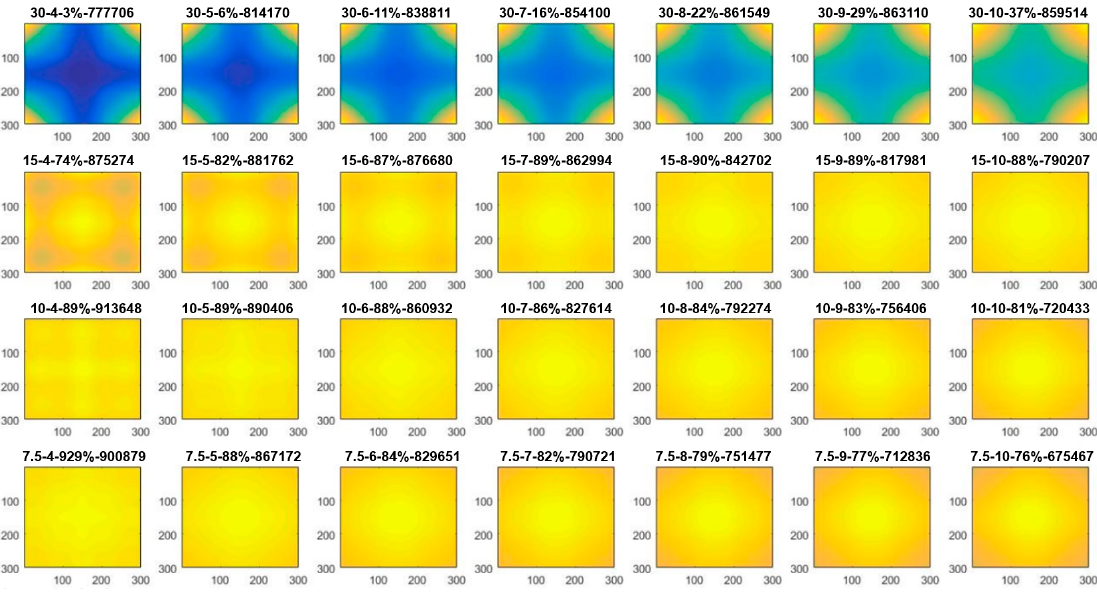
Figure 5. Array analysis of CSP.